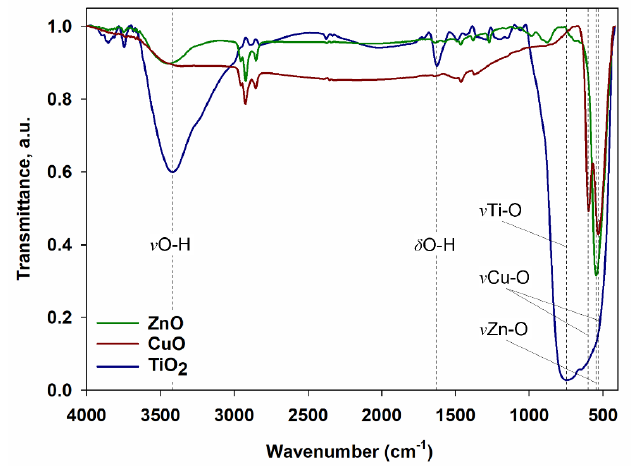
Figure 1. FTIR spectra of zinc oxide, copper(II) oxide and titanium(IV) oxide.